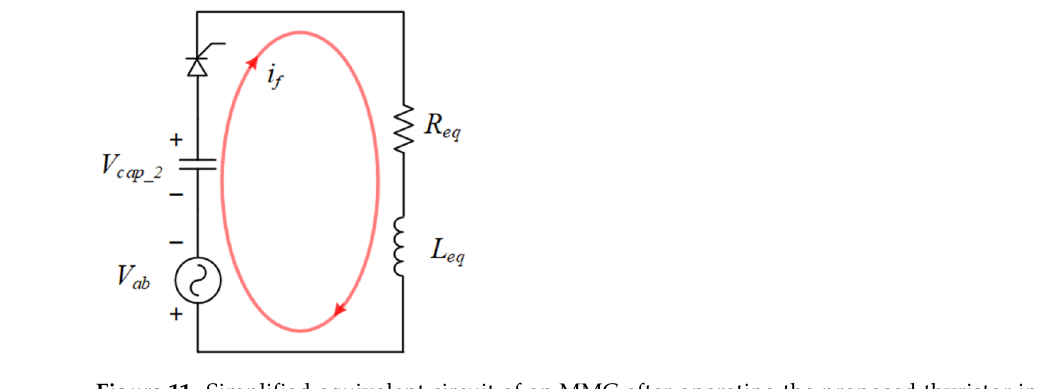
Figure 11. Simplified equivalent circuit of an MMC after operating the proposed thyristor in the sub-modules.